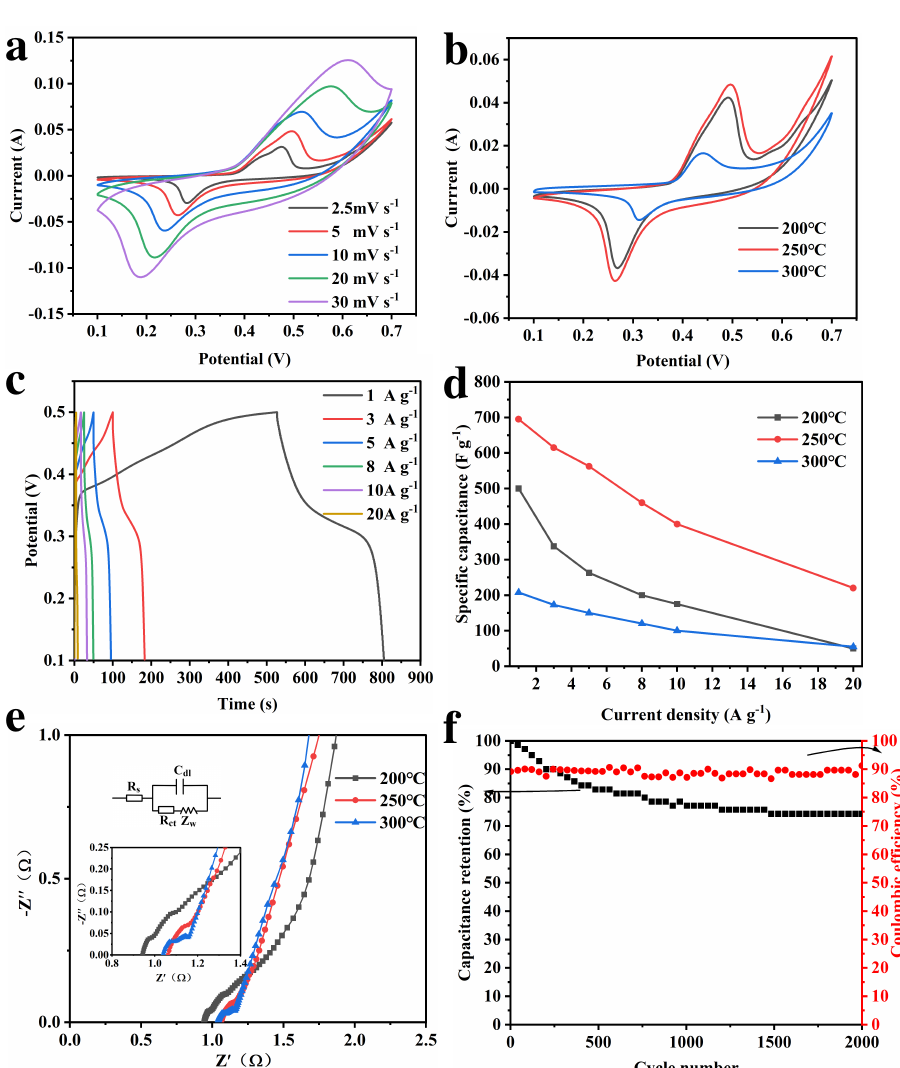
Figure 6. CV curves of CNFs@Ni(OH) 2 /NiO-250 at different sweep speeds ( a ). CV curves of CNFs@Ni(OH) 2 /NiO-X at 5 mV s − 1 sweep rate ( b ). GCD curves of CNFs@Ni(OH) 2 /NiO-250 at different current densities ( c ). Specific capacitance plots of CNFs@Ni(OH) 2 /NiO-X at different current densities ( d ). Nyquist plots of CNFs@Ni(OH) 2 /NiO-X ( e ). Cycling stability plots of CNFs@Ni(OH) 2 /NiO-250 ( f ).